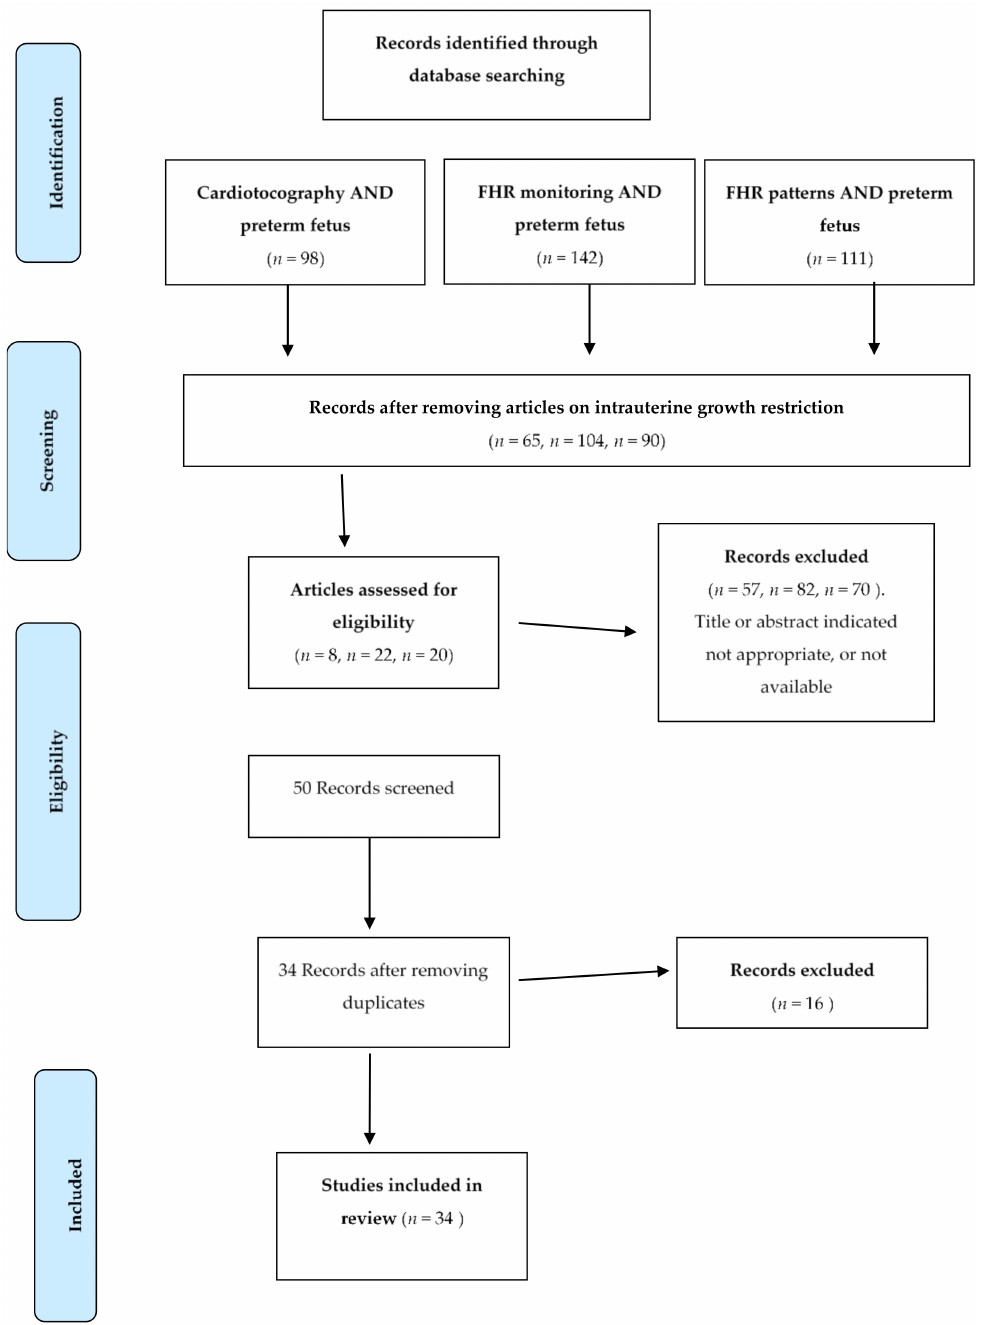
Figure 1. Flow diagram of identification of eligible studies. FHR: fetal heart